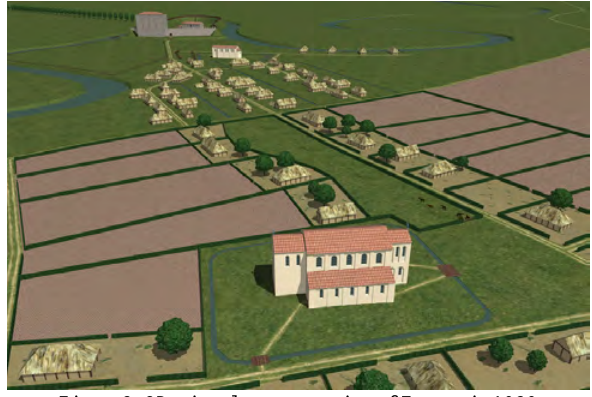
Figure 3. 3D virtual reconstruction of Ename in